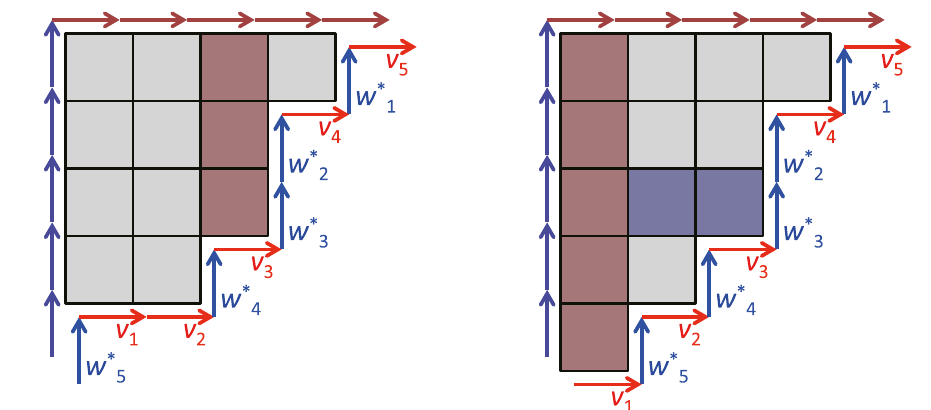
Figure 6 . A pictorial method to understand the extra signs in removing elements from the prod- uct [ v r (cid:1) (cid:1) (cid:1) v 1 ; w (cid:3) [ v 5 (cid:1) (cid:1) (cid:1) v 1 ; w (cid:3) seen explicitly from [ v 5 (cid:1) (cid:1) (cid:1) v 1 ; w (cid:3)